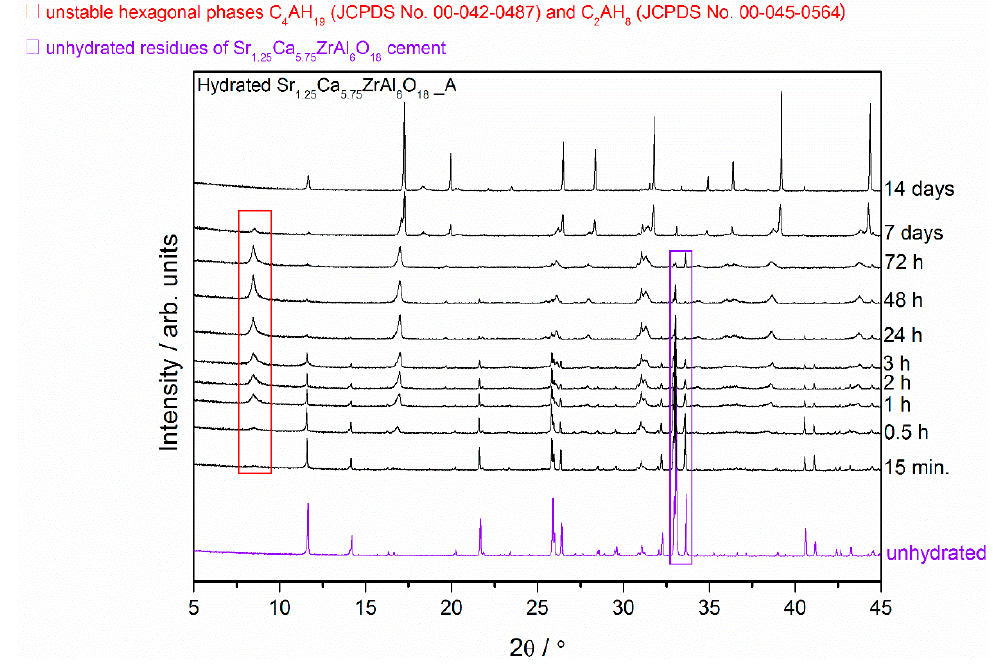
Figure 2. X-ray diffraction patterns of the Sr 1.25 Ca 5.75 ZrAl 6 O 18 cement paste (Sample A) at different curing periods from 15 min to 14 d compared with the XRD pattern of the unhydrated compound.